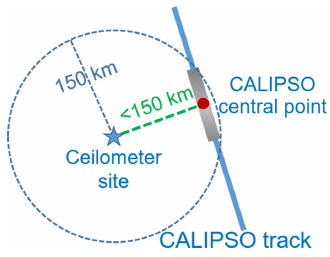
Figure 1. Schematic of matching between the CALIPSO and a ma- rine ceilometer observation site. The blue star indicates the location of the ceilometer site, the blue solid line is the CALIPSO track, the red solid circle represents the CALIPSO central point, the dashed green line represents the shortest distance from the ceilometer site to the CALIPSO central point, and the gray shaded area is the 1 ◦ CALIPSO scene. The blue circle is centered on the ceilometer site and has a radius of